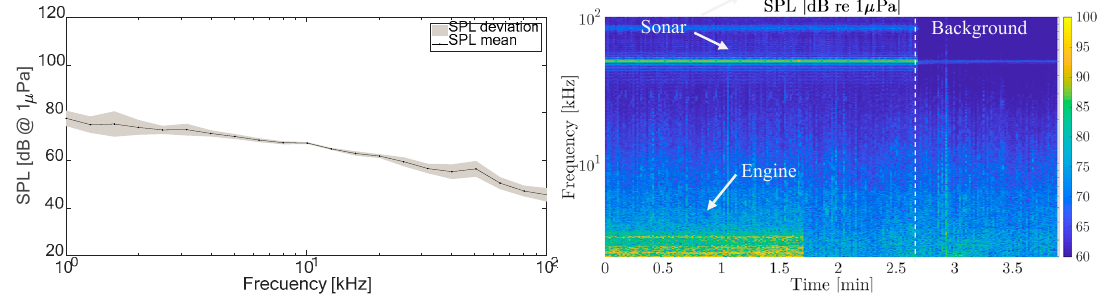
Figure 8. ( left ) Spectrum of background noise. ( right ) Its spectrogram at Point P1. SPL: sound pressure level.